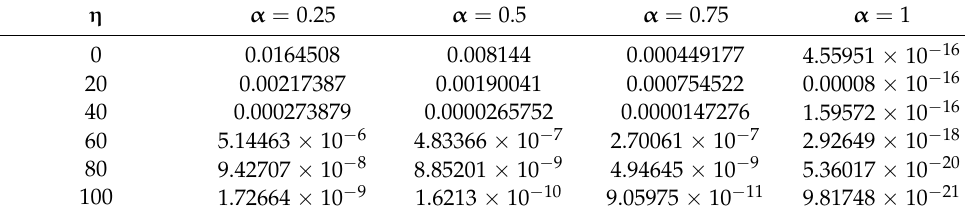
(cid:12) (cid:12) ( closed form solution ) − (cid:12)